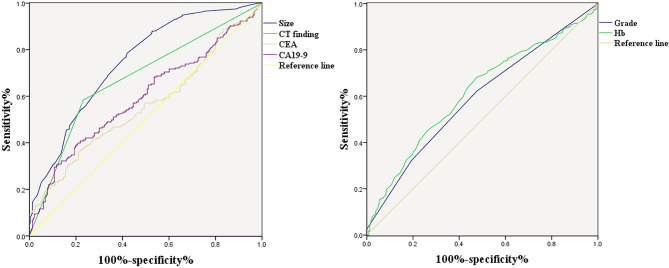
ROC curve of independent risk factors of LNM in GC, including CT finding, CEA, CA19-9, grade, and Hb.